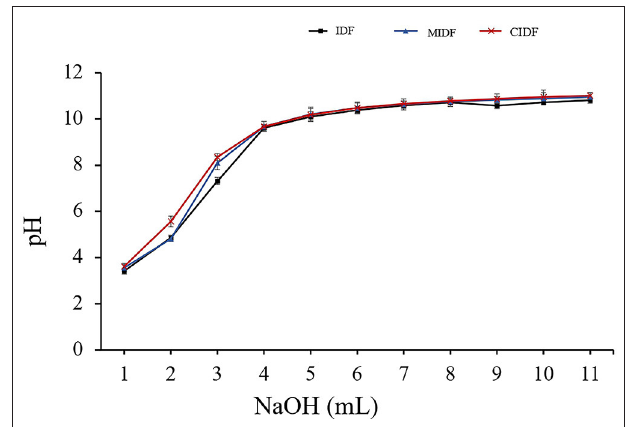
FIGURE 5 | Cation exchange capacity of insoluble dietary